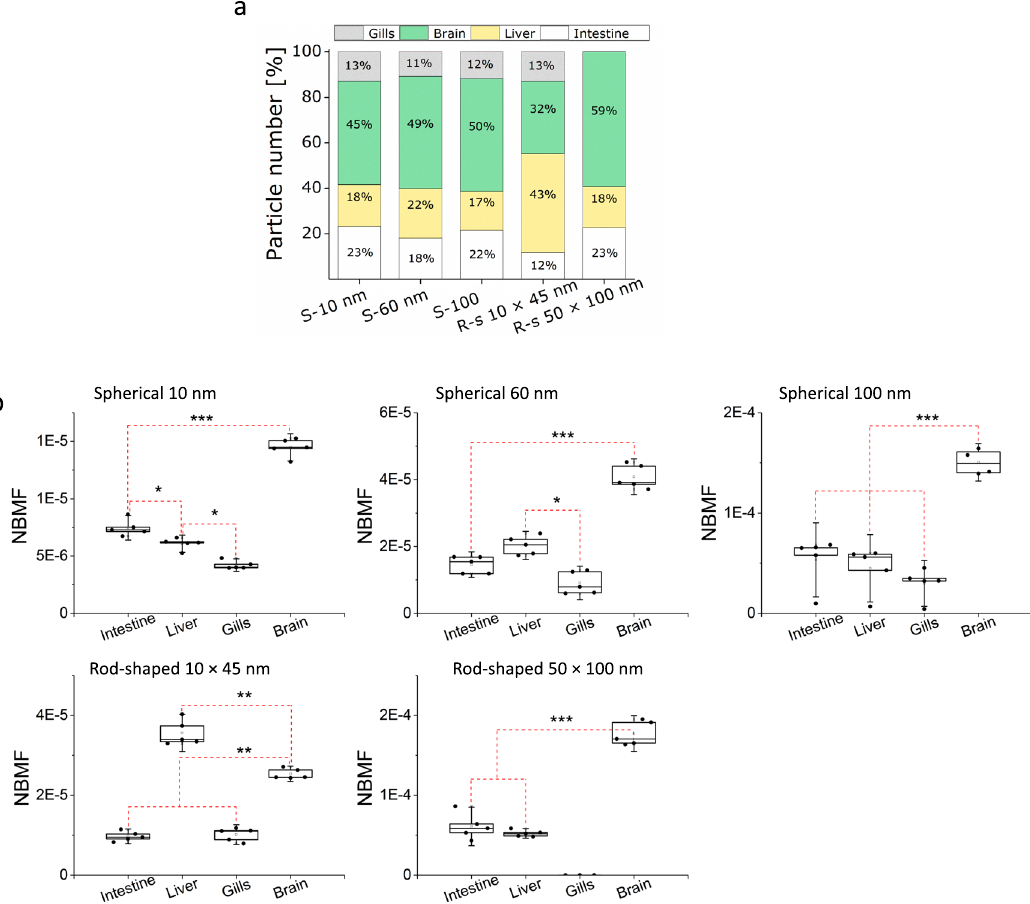
Fig. 4 Number-based biomagni fi cation factor (NBMF). a Percentage of the total accumulated particle number in different tissues of fi sh ( n = 5). The graph shows the number-based biodistribution of the Au-NMs in fi sh as a function of particle shape and size. b NBMFs of the Au-NM in fi sh obtained by dividing the concentration of the Au-NM in tissues of fi sh by the concentration of the Au-NMs in the algae. Data ( n = 5) were analysed using one-way ANOVA followed by Duncan ’ s post hoc test ( b ) (*** p < 0.0001; ** p < 0.001; * p < 0.05). Box plots ( b ) indicate median (middle line), 25th, 75th percentile (box), and SD